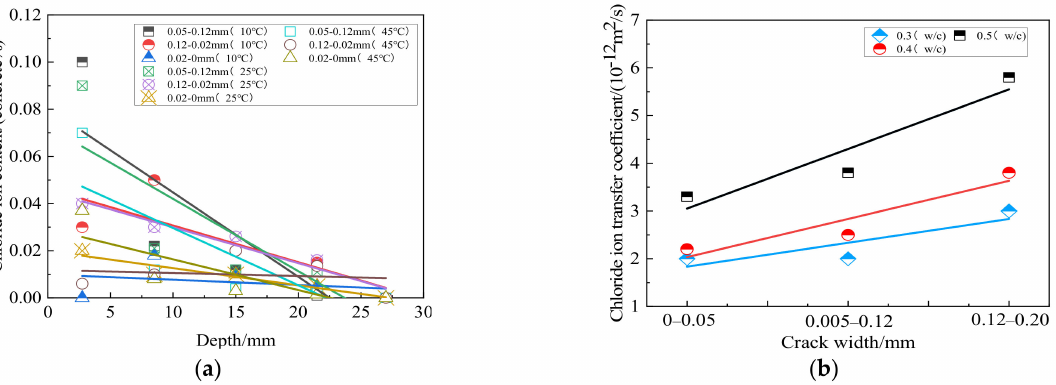
Figure 16. ( a ) Effects of different penetration depths, curing temperatures and crack widths on electric flux [90]; ( b ) Effects of different water—cement ratios and crack widths on chloride ion transfer coefficient [90].